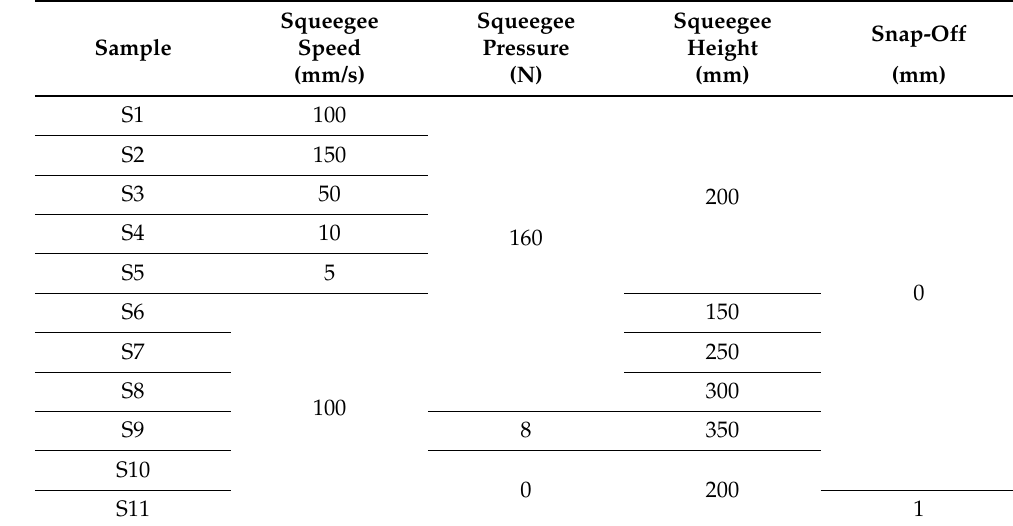
Table 2. Printing parameters for the pressure sensor